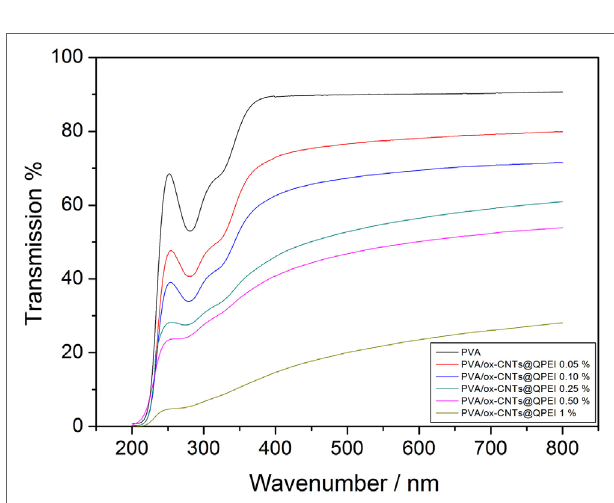
FigUre 6 | TEM micrographs of PVA/ox­CNTs@QPEI 1.0% nanocomposite